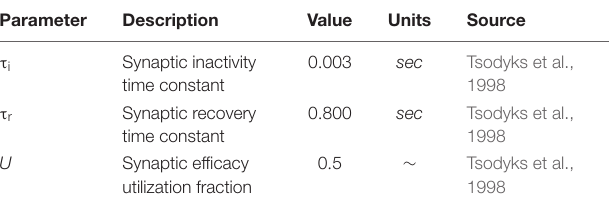
TABLE 3 | Presynaptic resource model